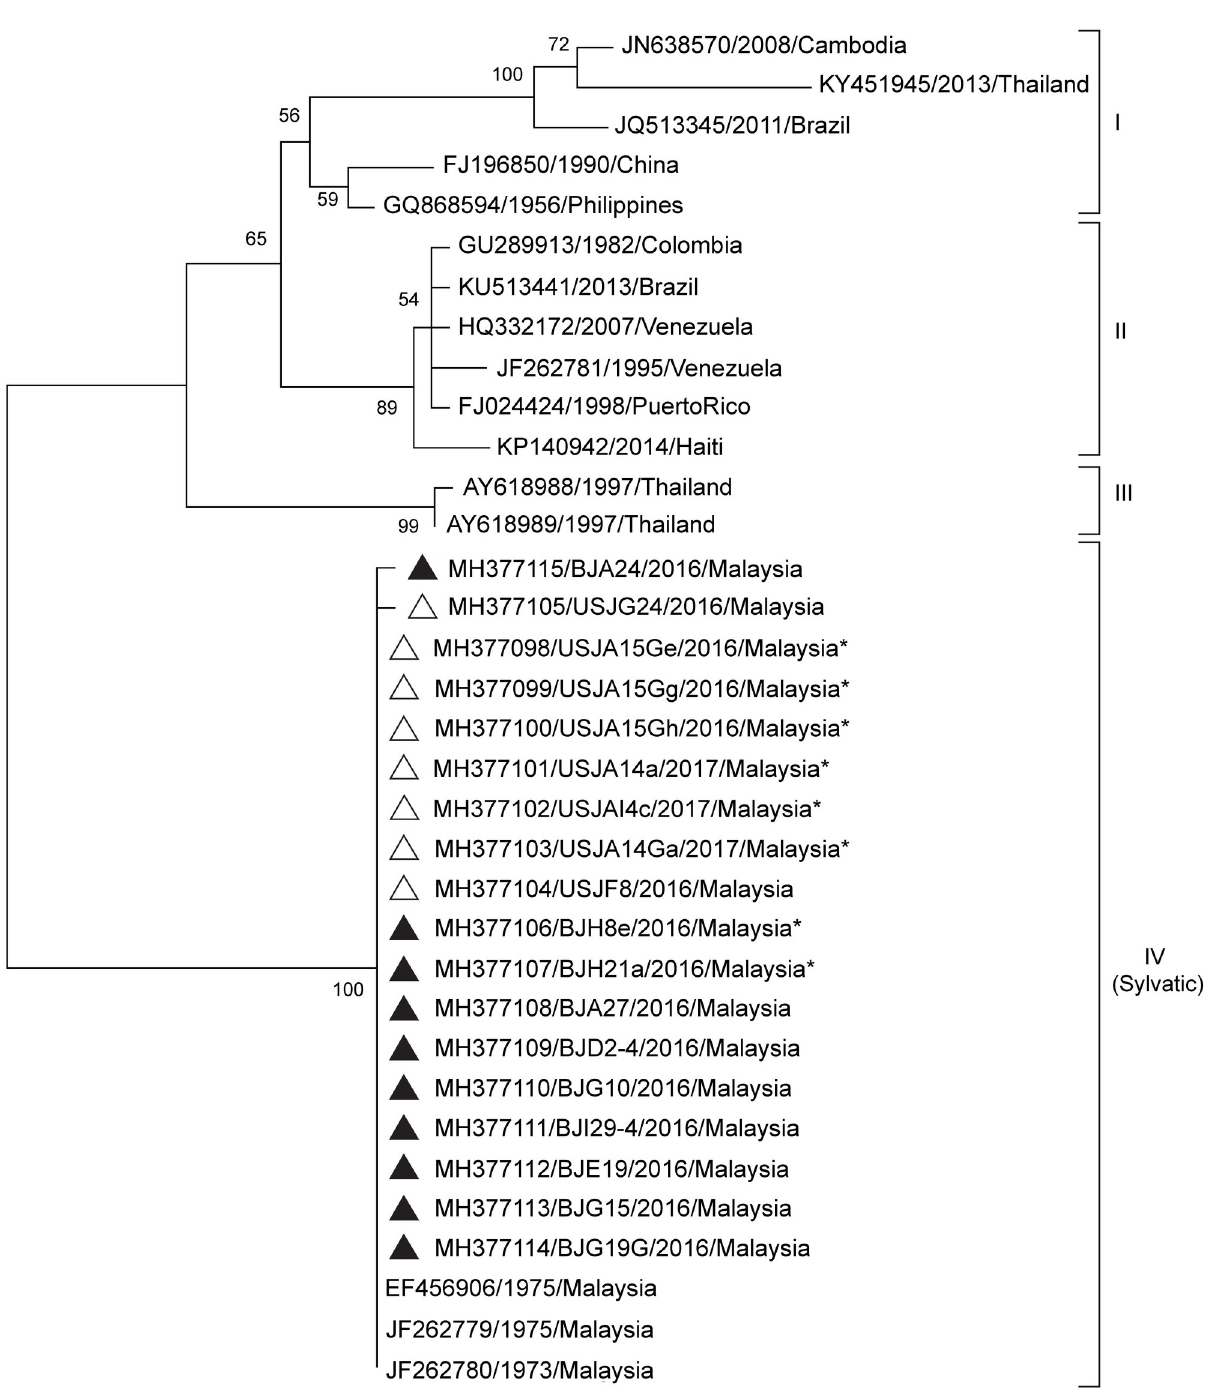
PLOS NeglectedTropical Diseases | https://doi.org/10.1371/journal.pntd.0007889 November15,